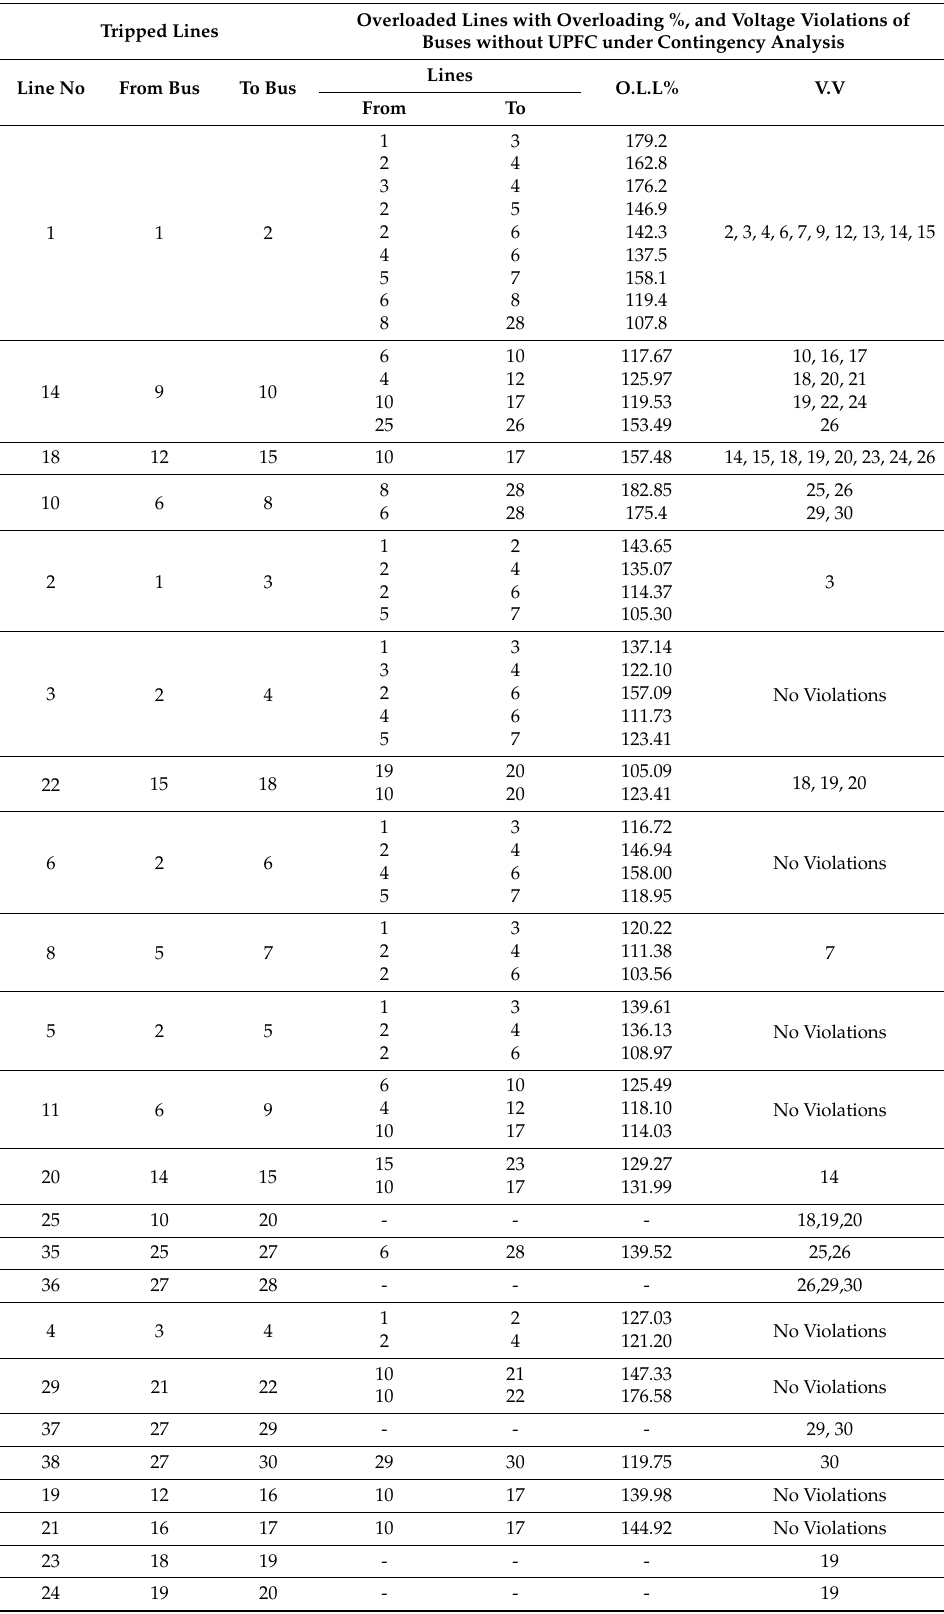
Table 8. Overloading lines with percentage and bus voltage violations without UPFC. Tripped